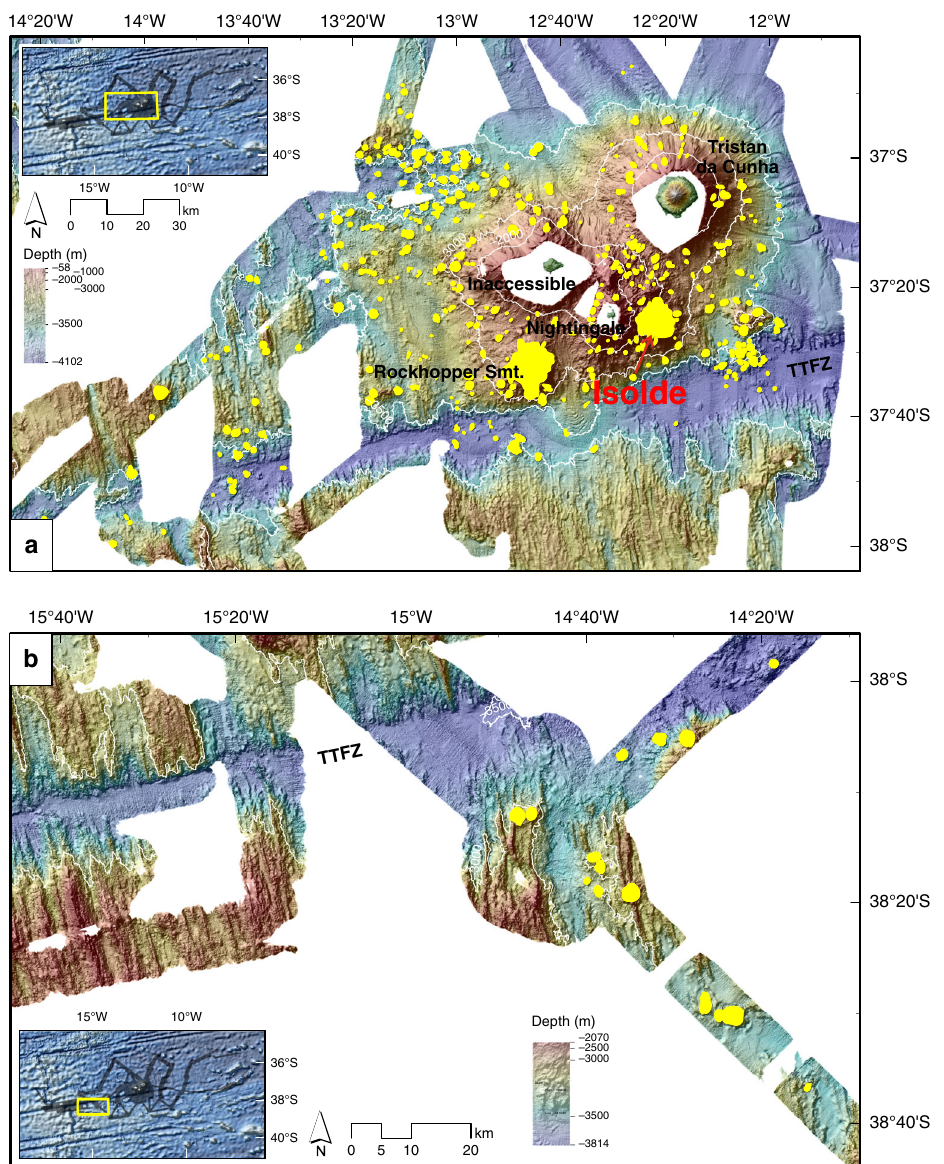
Fig. 7 Thematic maps of identi fi ed volcanic cones. a Bathymetry for the central area with identi fi ed volcanic cones. b Bathymetry for the western area with identi fi ed volcanic cones. The hillshade is illuminated by an azimuth of 315°. Smt. Seamount; TTFZ Tristan da Cunha Transform Fault And Fracture Zone